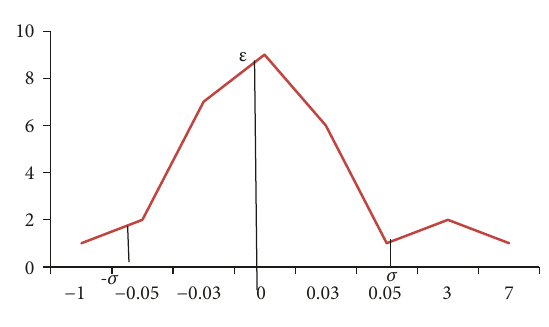
Figure 3: The distribution of Δ